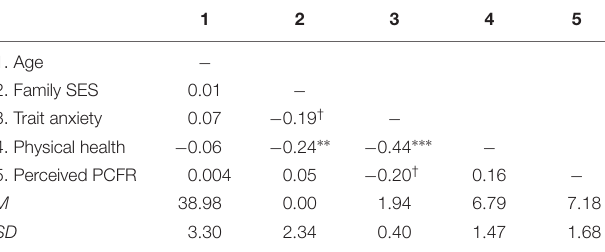
TABLE 1 | Descriptive statistics and correlations among variables in study 2 ( N =